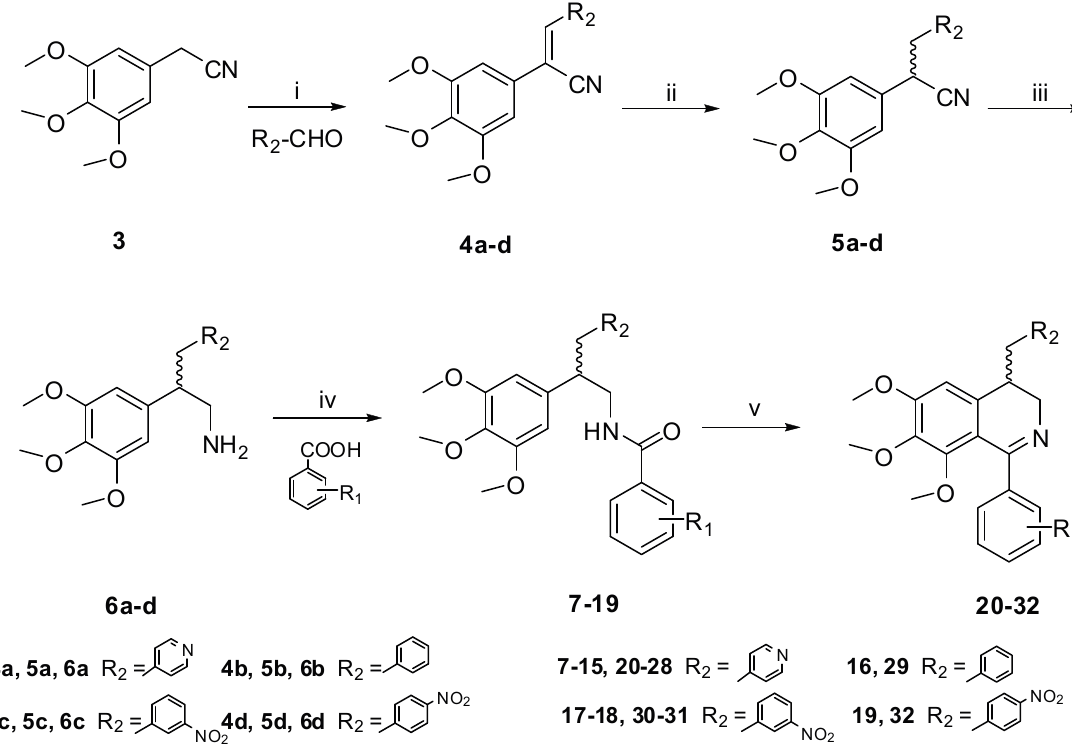
Scheme 1. Synthetic route of the target compounds. Reagents and conditions: (i) NaOH, EtOH, 0 °C, 0.5 h, 85%; (ii) NaBH 4 , MeOH, 0 °C, 0.5 h, 86%; (iii) BF 3 , NaBH 4 , THF, 0 °C, 96%; (iv) EDC, DMAP, CH 2 Cl 2 , 25 °C, 59%–85%; (v) CH 3 CN, POCl 3 , reflux, 3 h,